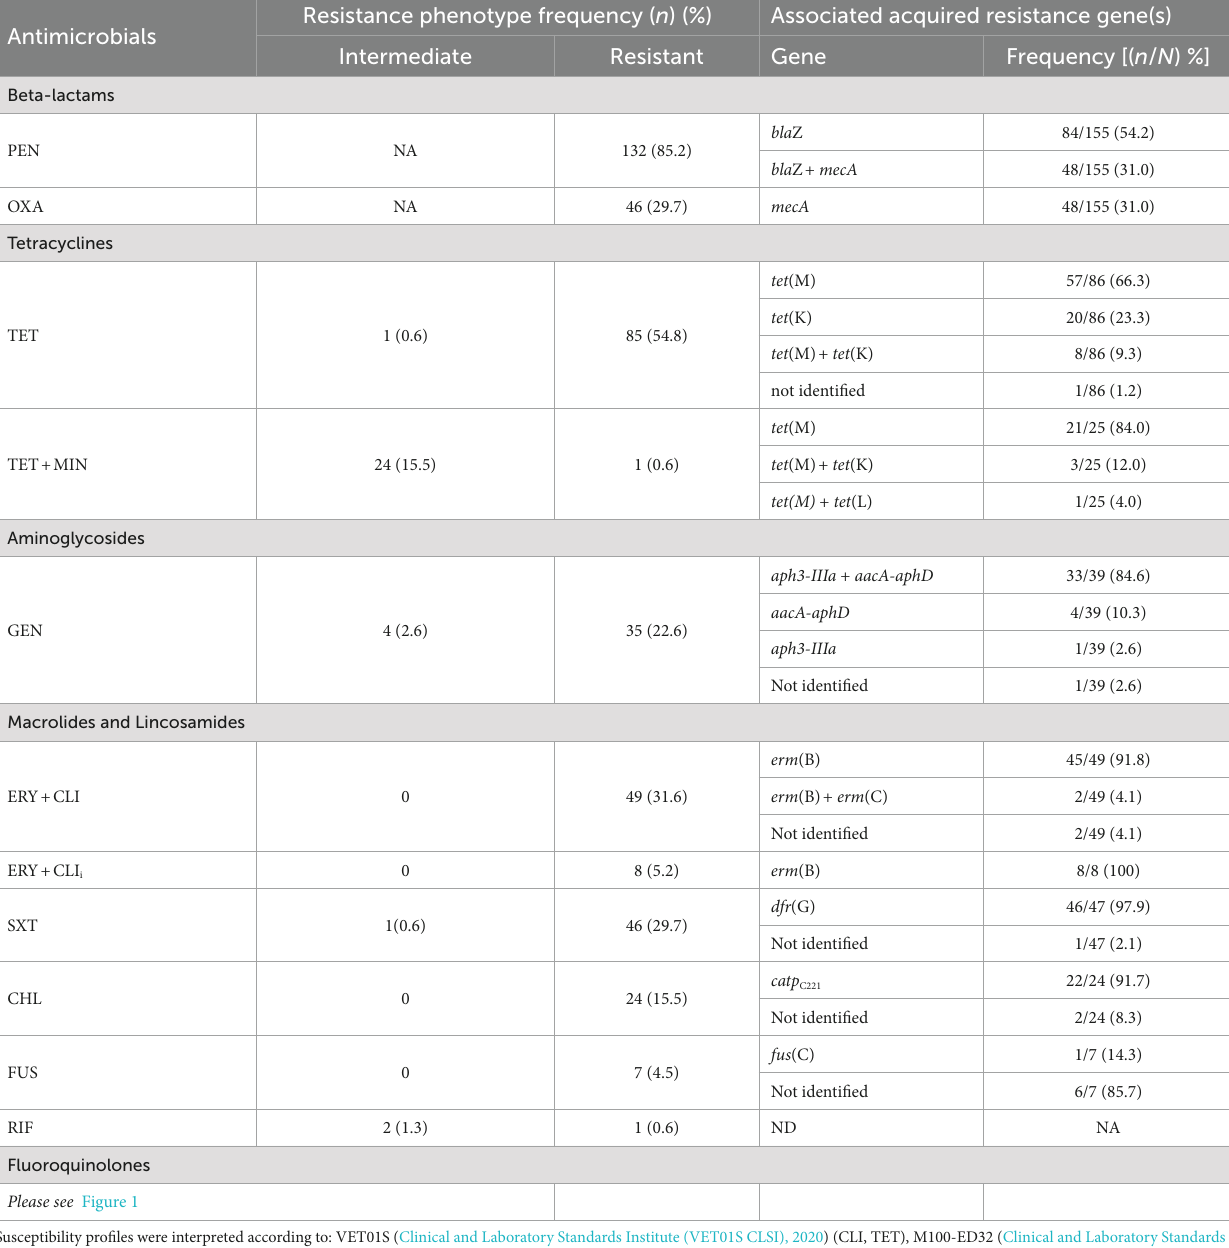
TABLE 1 Distribution of antimicrobial resistance phenotypes among the 155 S. pseudintermedius studied and associated acquired resistance